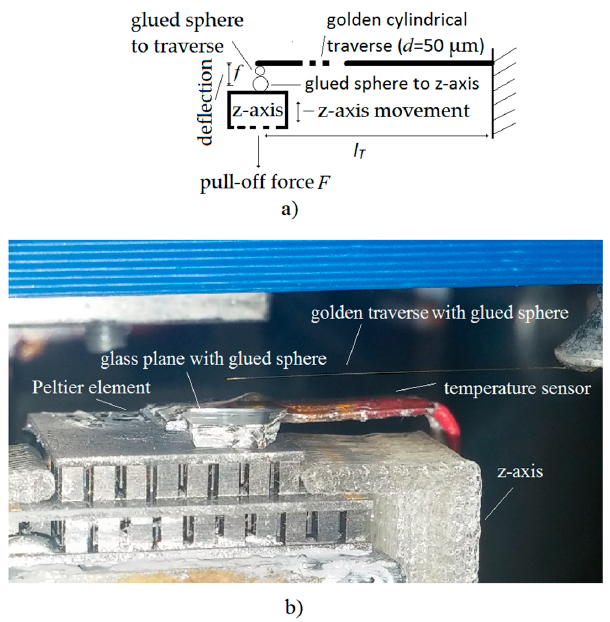
Figure 5. Measurements of the pull-off force: ( a ) description of a pull-off method; ( b ) lab test-bed for pull-off method.